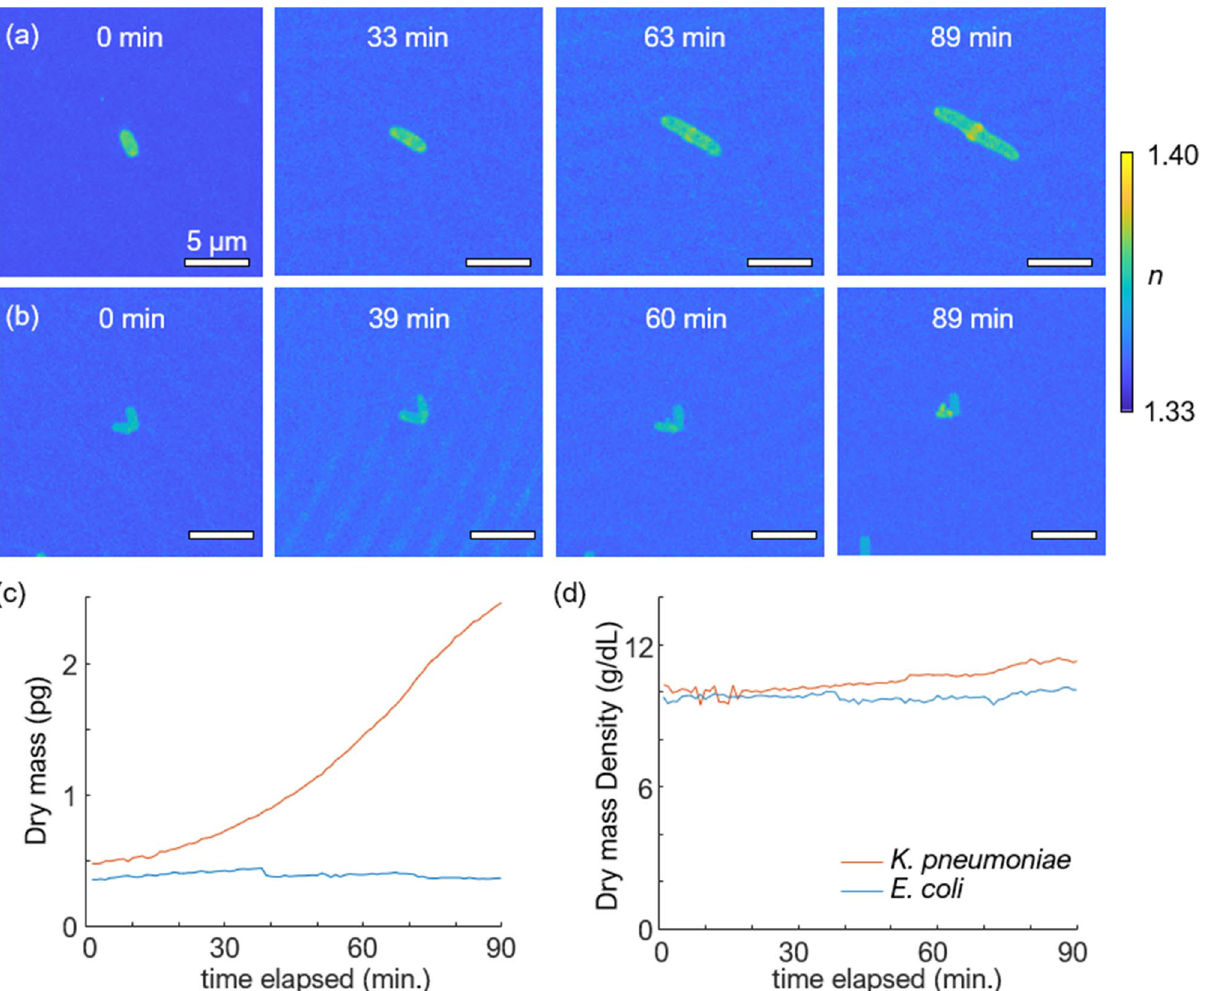
Figure 6. ( a ) MIP visualization of 3D RI tomograms of K. pneumoniae ( a ) and E. coli ( b ) treated with 200 μg/ mL of ampicillin. Quantitative analysis of dry mass ( c ) and dry mass density ( d ) over time for K. pneumoniae and E. coli were plotted